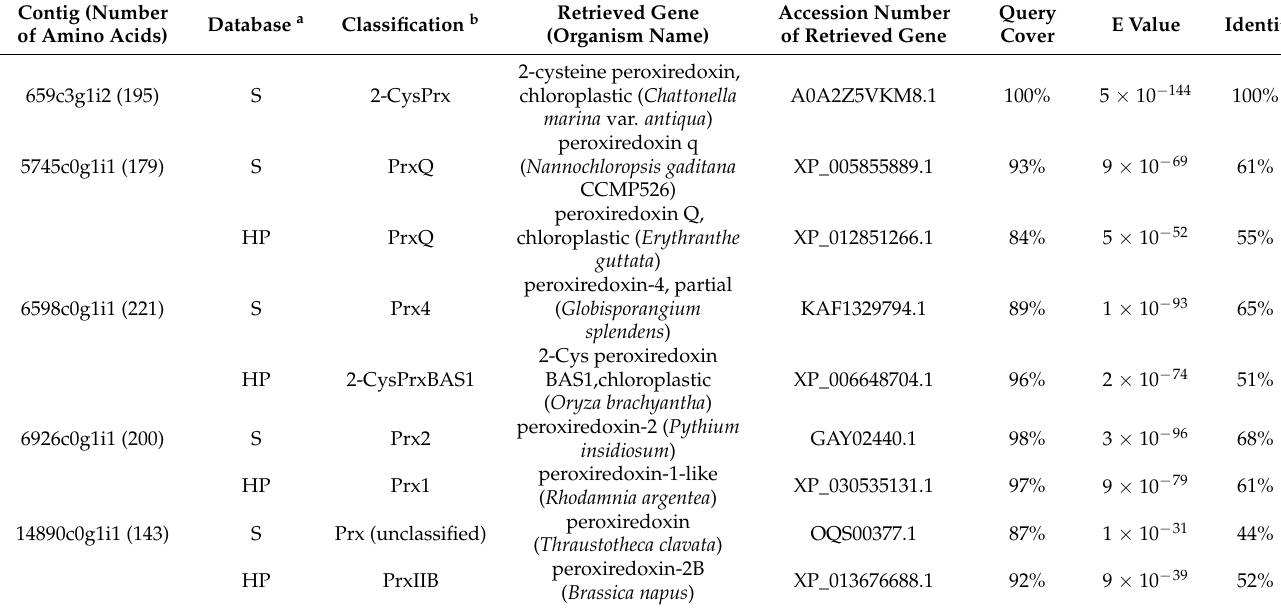
Table 2. Five Prx-family genes in Chattonella marina identified by a BlastP search using the database for stramenopiles and higher plants.